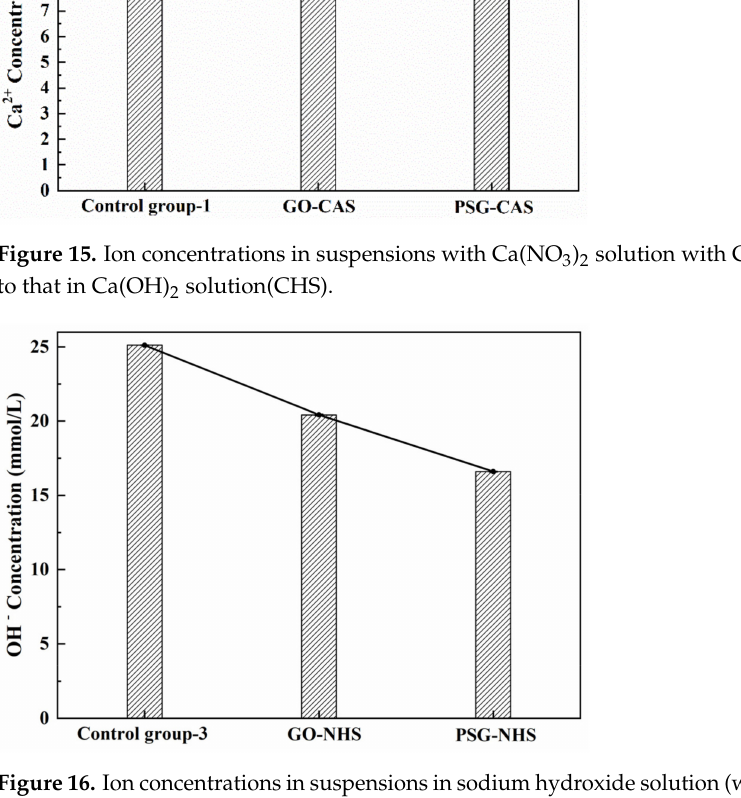
Figure 16. Ion concentrations in suspensions in sodium hydroxide solution (with OH − concentrations equal to that in Ca(OH) 2 (CHS) solution).